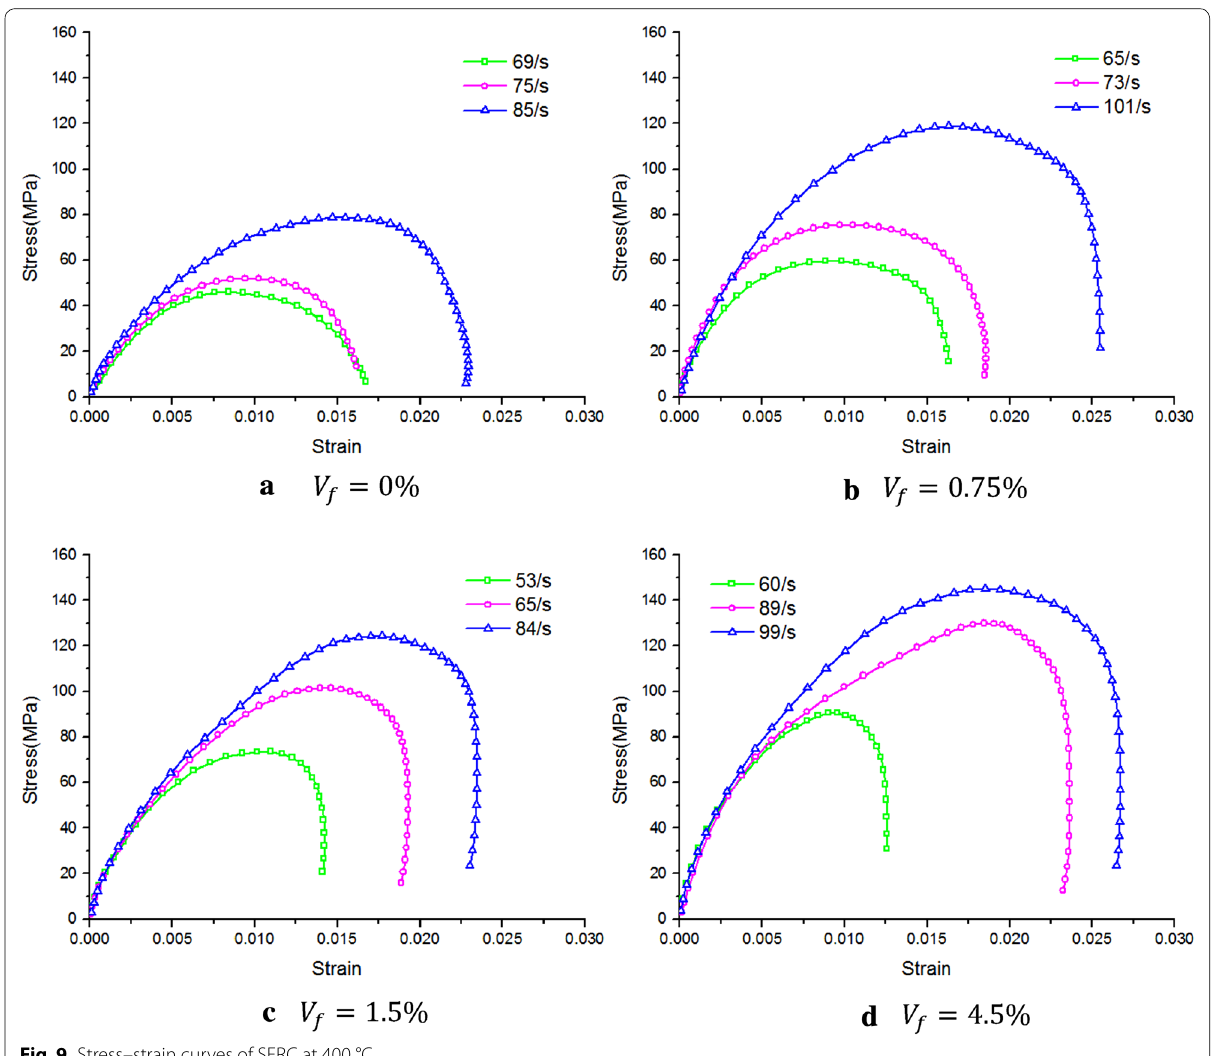
Fig. 9 Stress–strain curves of SFRC at 400 °C.